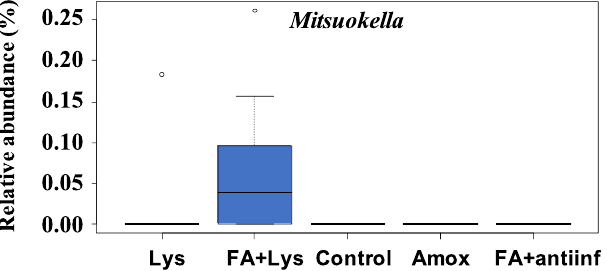
Figure 5. Analysis of composition of microbiomes (ANCOM) on fecal microbiota at genus level comparing groups after treatment (D21). Mitsuokella genus was dected with this differential abundance test. The mean relative abundance of this genus is shown in percentage. Each boxplot corresponds to one treatment group: Lys lysozyme, FA + lys medium chain fatty acids and lysozyme, C control, with no additives, Amox amoxicillin, FA + antiinf medium chain fatty acids and a natural anti-inflammatory. The dotted lines represent standard deviation and outliers are indicated with white